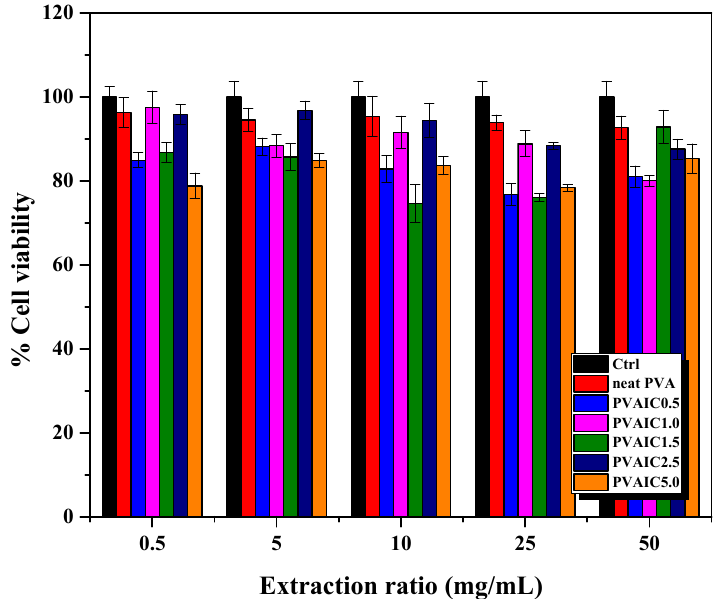
Figure 7. Indirect cytotoxicity of PVA hydrogels loaded with various amounts of quercetin/HP- β -CD inclusion complex with extraction medium: neat PVA, 0.5, 5, 10, 25, and 50 mg/mL cultured with NCTC 929 clone cells.